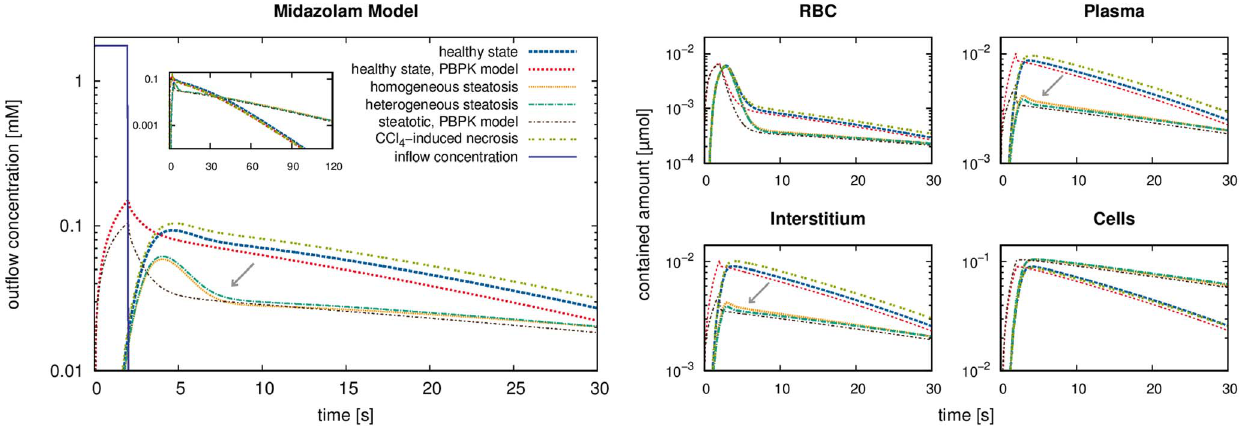
Figure 9. Simulations with a spatially resolved model for midazolam. The large plot (left) shows the outflowing midazolam concentrations for the healthy state and the pathological states for a midazolam inflow during 2 seconds. For comparison, results for simulations with a PBPK model are shown as well. The four smaller plots (right) show the total amounts contained in the subspaces of the liver, using the same lines and colors. Here, a difference between healthy and pathological states can be observed. In case of CCl 4 -induced necrosis, higher outflow concentrations are predicted whereas they are lower in the steatotic cases. In particular, the outflow concentration as well as the amounts contained in the plasma and the interstitium also show a difference of up to 7 : 4 , 8 : 7 , and 8 : 8 percent, respectively, between the homogeneous and heterogeneous steatotic states (marked by arrows).